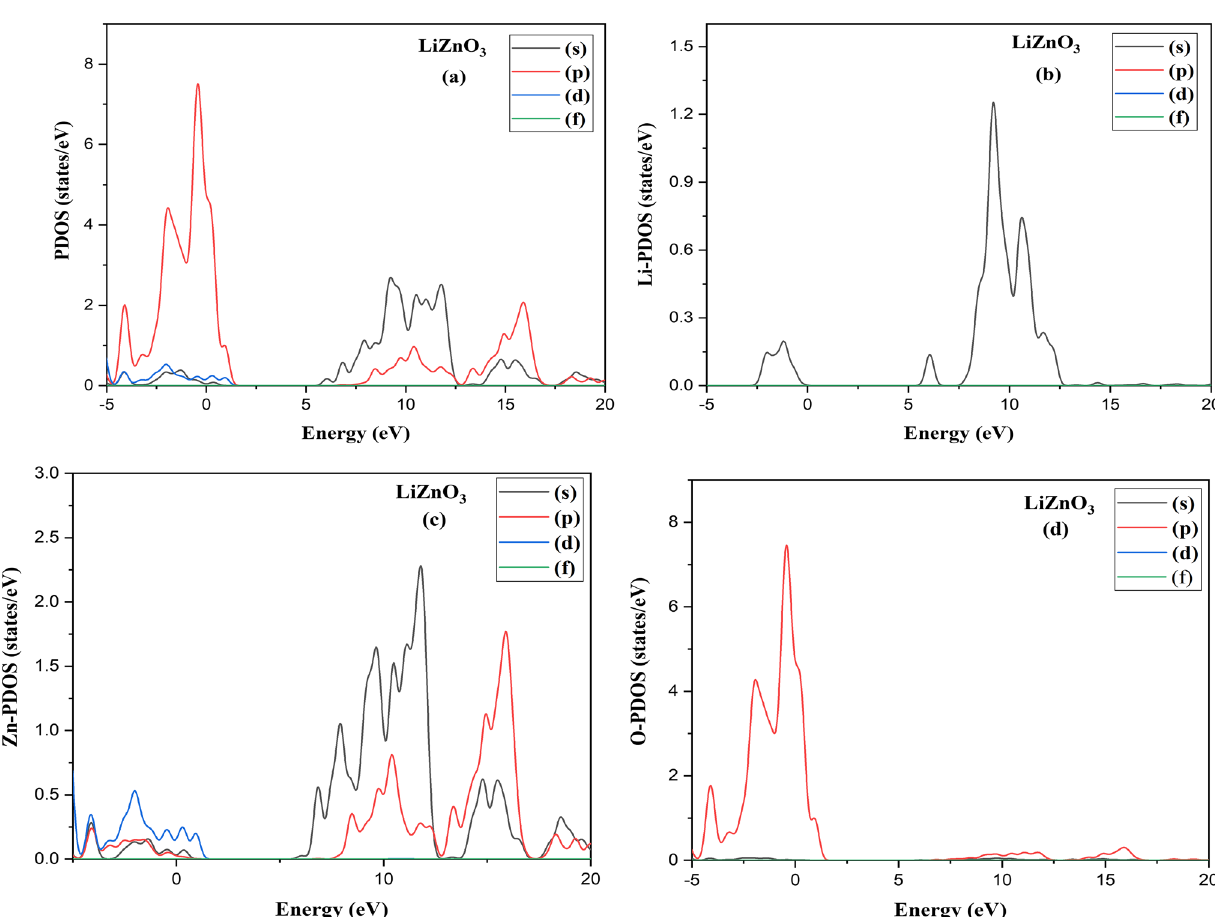
Fig. 5 a Partial DOS b Li-PDOS and c Zn-PDOS, and d O-PDOS LiZnO